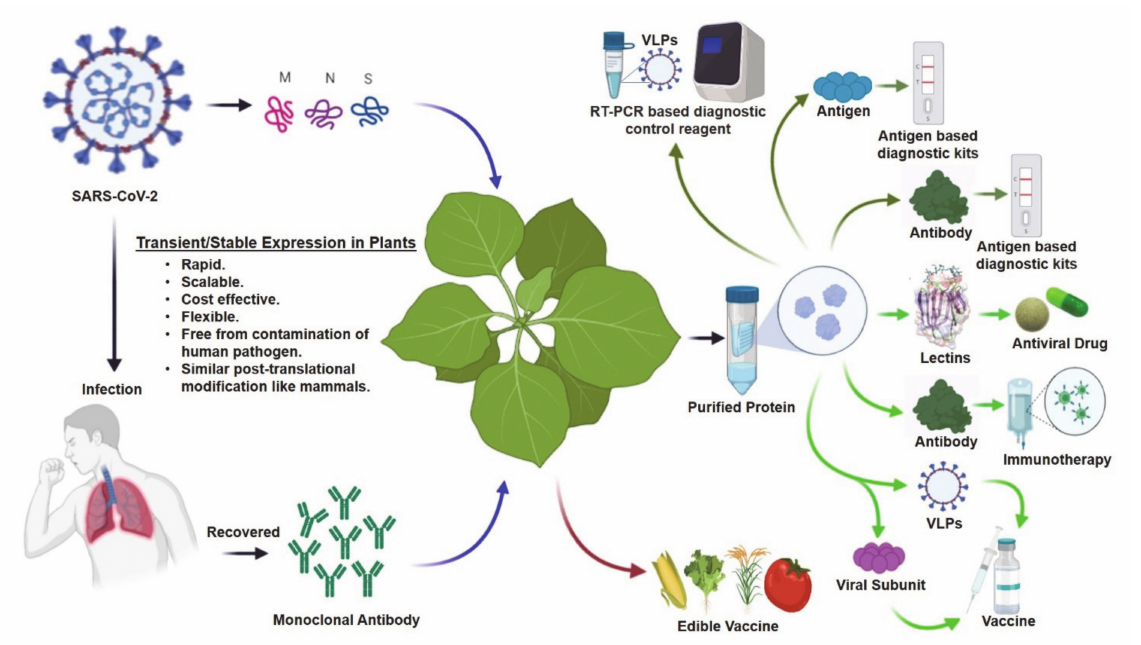
Figure 1. Developmental routes for plant-based diagnostics and therapeutics to address the COVID-19 crisis. Blue arrows indicate transient expression; brown arrow indicates stable expression; olive green arrows indicate potential routes for diagnostics; and light green arrows indicate potential routes for therapeutics manufacturing platforms. SARS-CoV-2: severe acute respiratory syndrome coronavirus 2; VLPs: virus-like particles. Some of these images were generated using Biorender